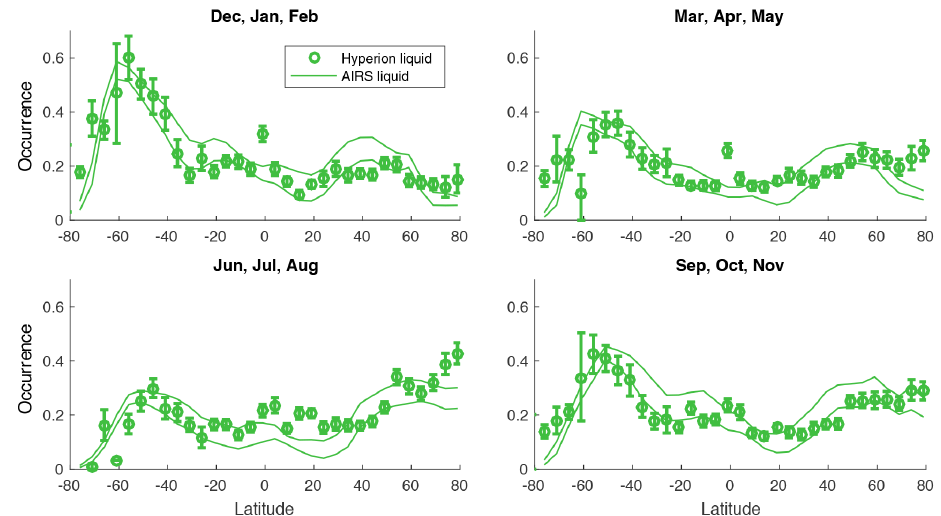
Figure A1. A comparison similar to Fig. 7 without normalization across latitudes. Two thin lines represent AIRS retrievals using the standard effective cloud fraction retrieval threshold of 0.5 and 0.1.